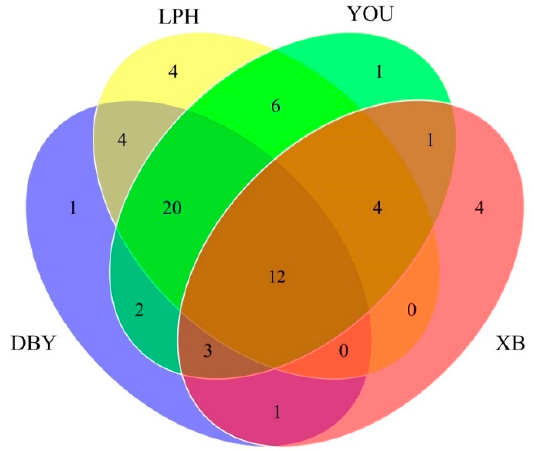
Figure 2. The Venn diagram of volatile compounds in four different apricot cultivars. DBY, Dabaiyou apricot; LPH, Luopuhongdaike apricot; YOU, You apricot; XB, Xiaobai apricot.